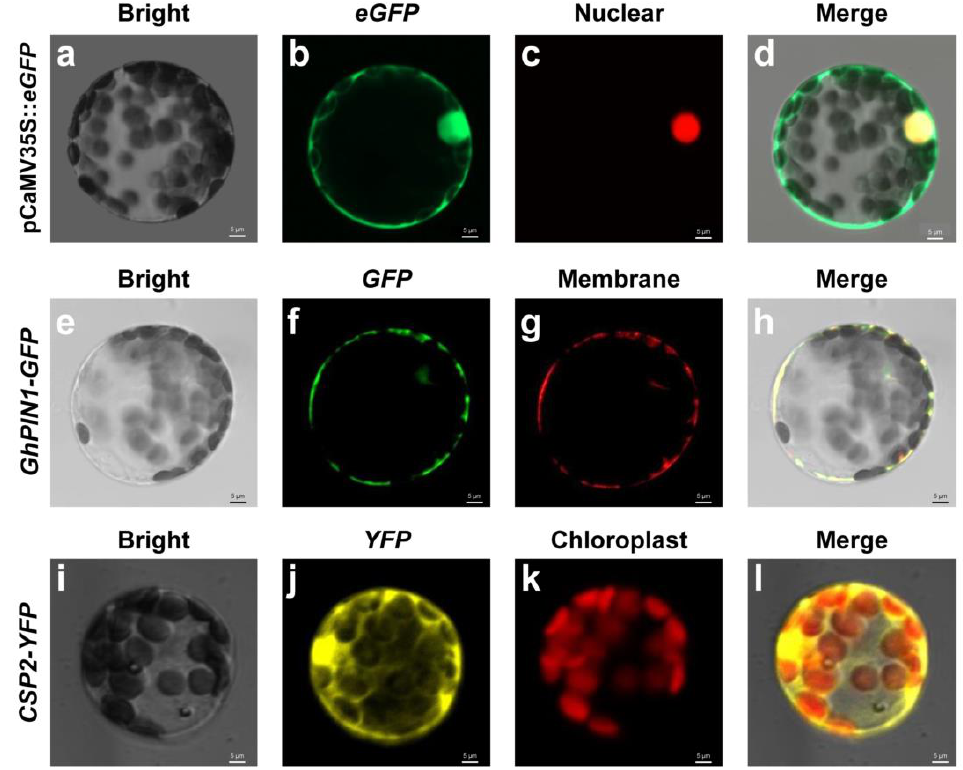
Figure 5. Subcellular localization of marker proteins. Cotton protoplasts transformed with ( a – d ) pCaMV35S:: eGFP , containing mCherry as a nucleus marker; ( e – h ) pCaMV35S:: GhPIN1 - eGFP , containing mCherry as a plasma membrane marker; and ( i – l ) pCaMV35S:: CSP2 - YFP , containing mCherry as a chloroplast marker. Scale bars = 5 μm.